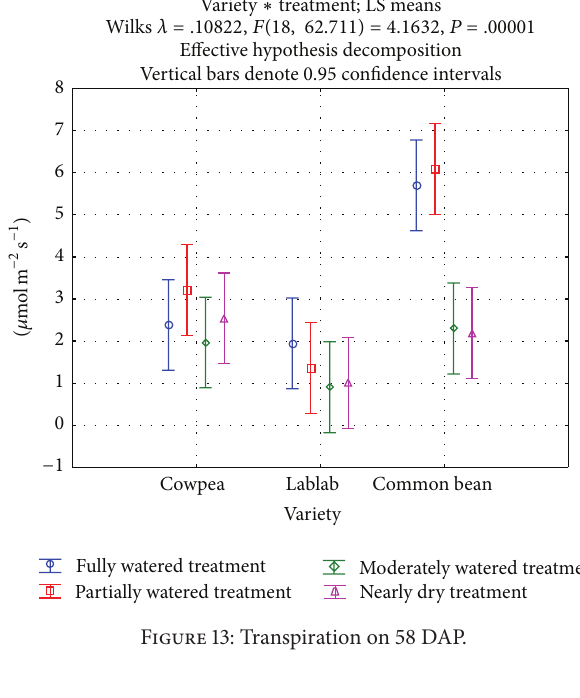
Figure 11: Stomatal conductance on 58 DAP.